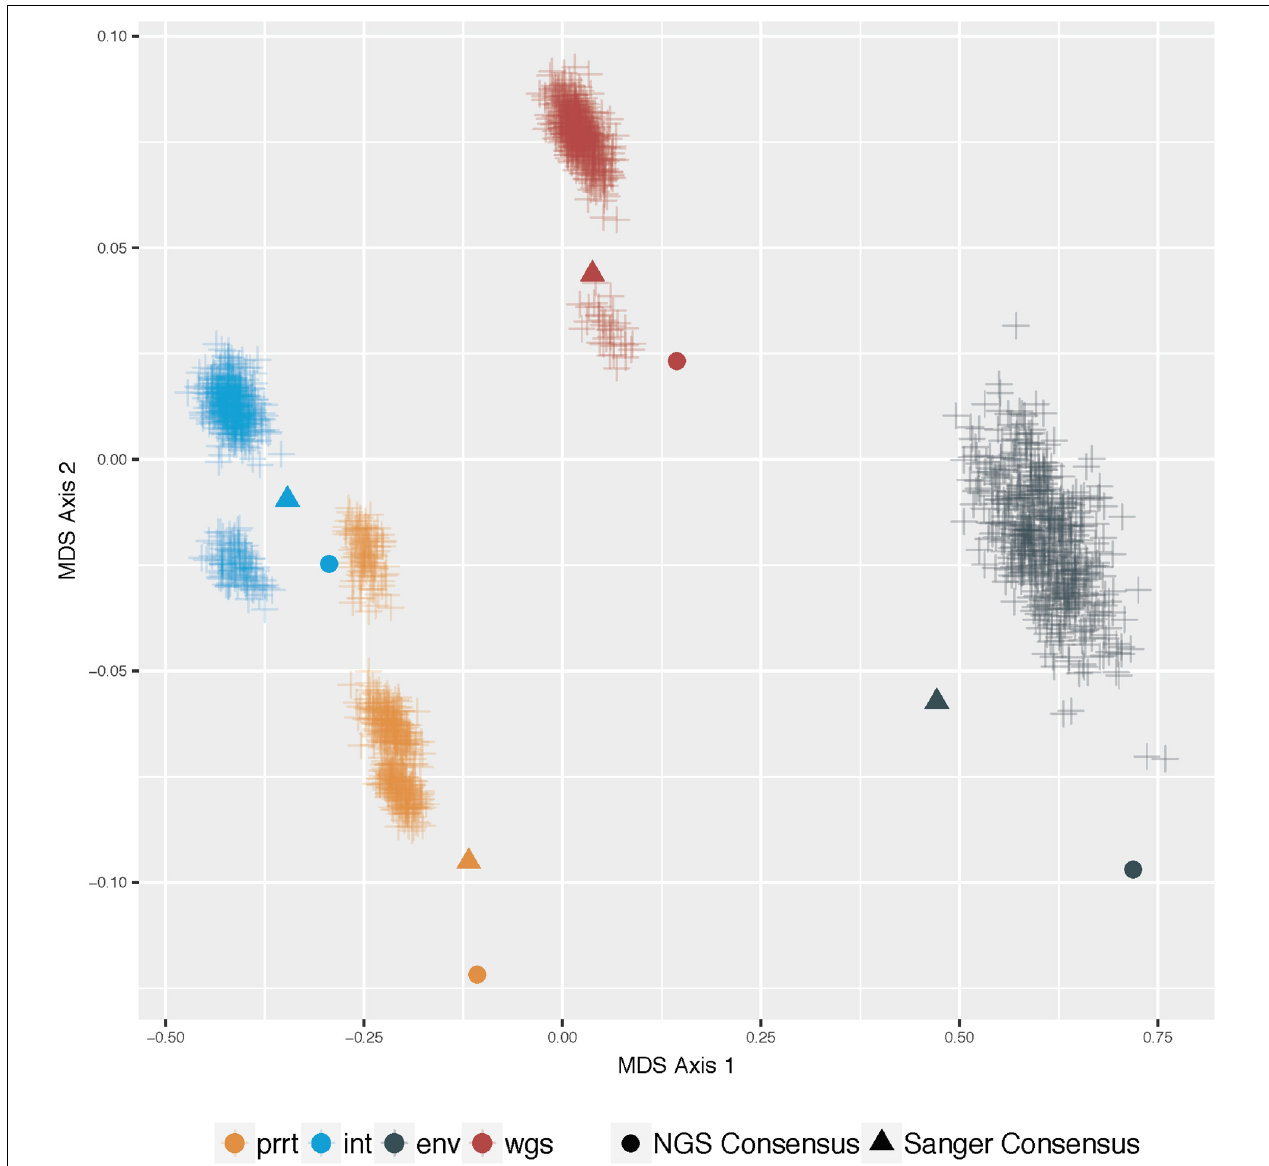
FIGURE 4 | Multi-dimensional scaling (MDS) of pairwise geodesic distance among maximum-likelihood phylogenies from the profile-sampling approach across all genomic regions. MDS Axis 1 ( X axis) and Axis 2 ( Y axis) show that the space of inferred phylogenies is multi-modal for all genomic regions. The phylogenies from consensus sequences (dot and triangle) are point estimates that do not capture the full variation in phylogenies that can be inferred from deeply-sequenced NGS data (plus signs) in all examined genomic regions